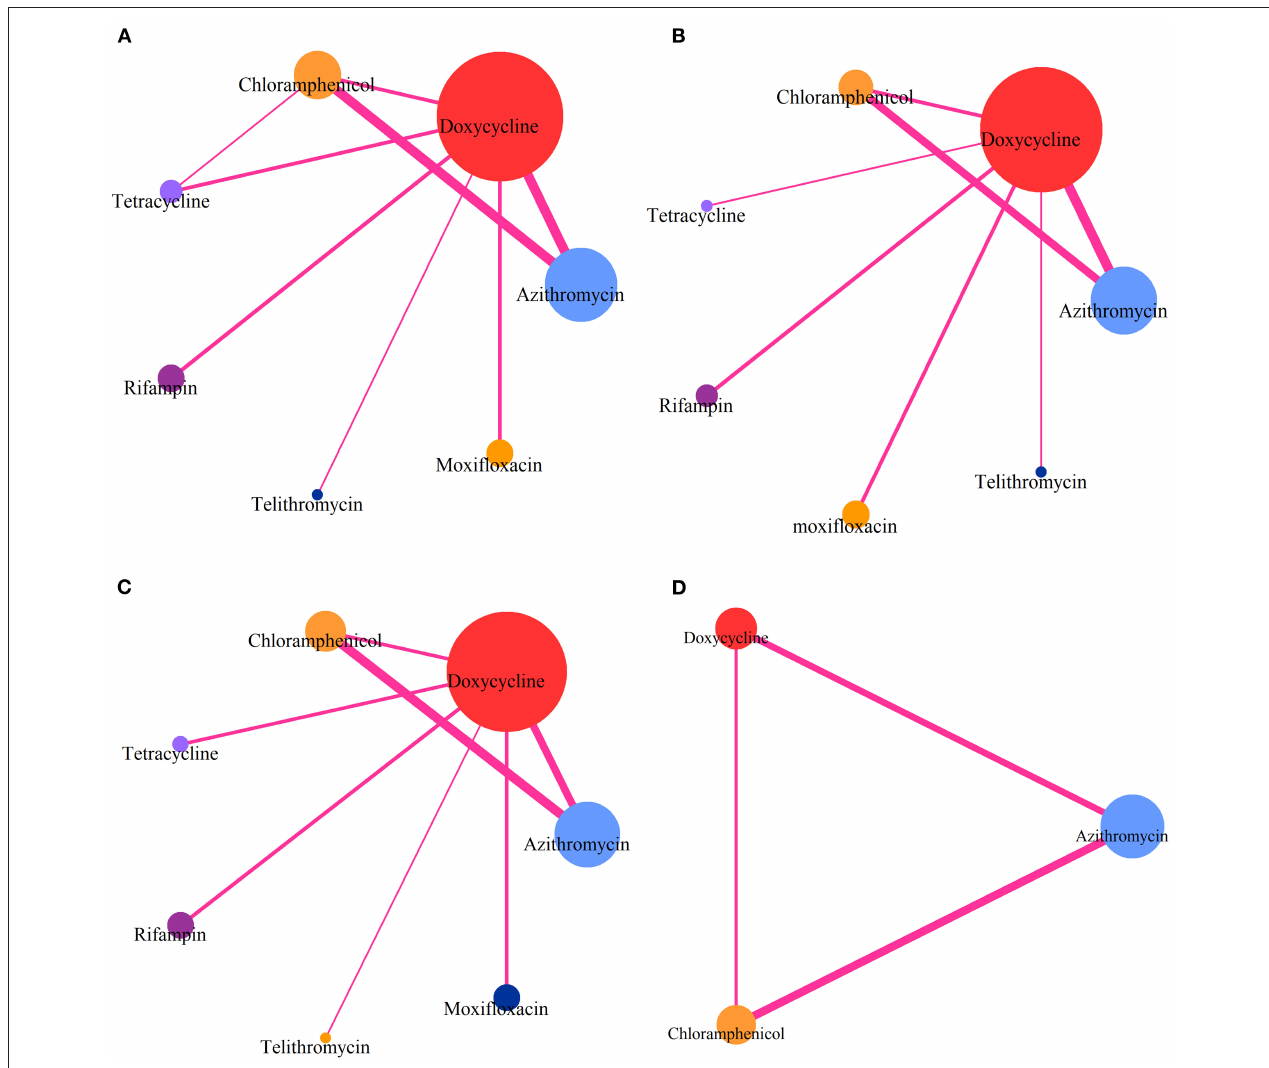
FIGURE 2 | Comparative network plots. (A) Comparisons on CR in patients with advanced scrub typhus. (B) Comparisons on risk of DT in patients with advanced scrub typhus. (C) Comparisons on GS-AD in patients with advanced scrub typhus. (D) Comparisons on ABC-AD with advanced scrub typhus. The node size is proportional to the total number of patients receiving a treatment. Each line represents a type of head-to-head comparison. The width of lines is proportional to the number of trials comparing the connected